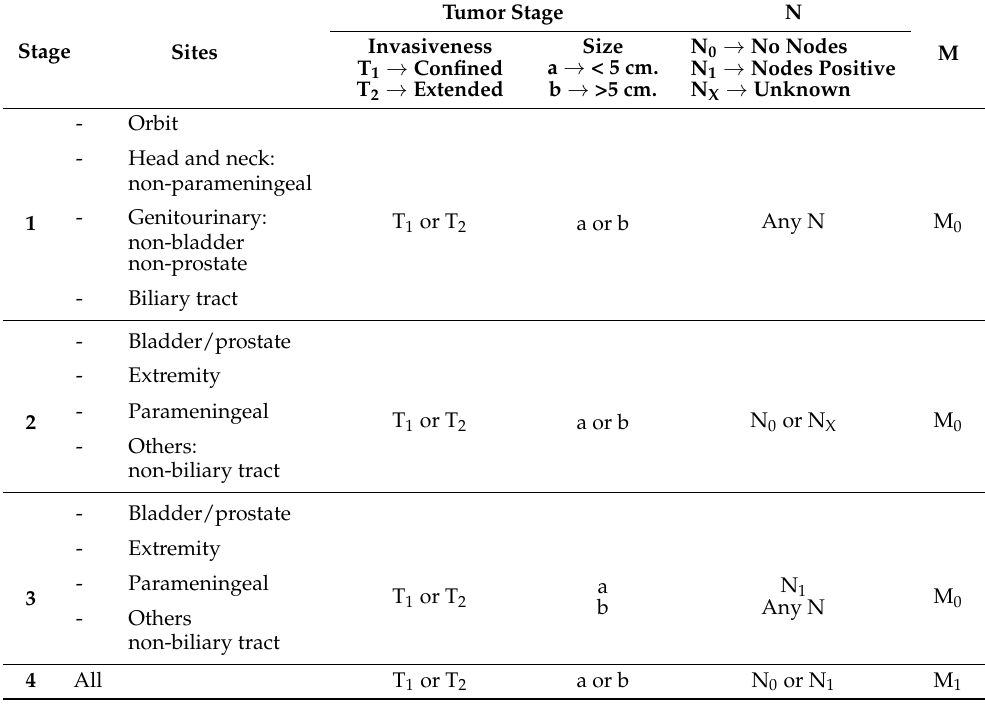
Table 1. TNM staging for